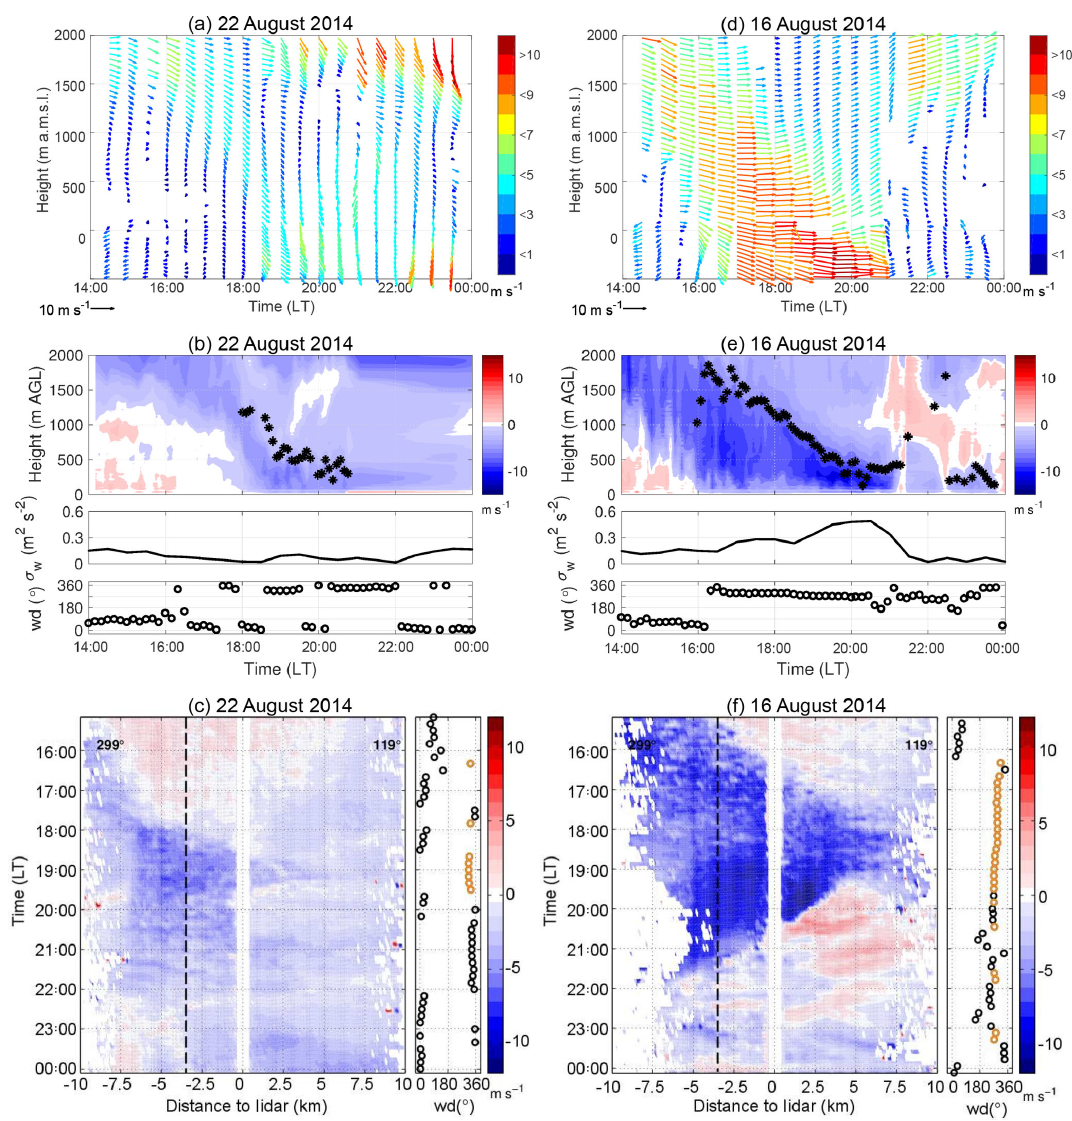
Figure 5. Example for a short and weak foehn event (a, b, c) and for a strong foehn event (d, e, f) . Shown are 10min mean vertical profiles of horizontal wind at the KITcube location (a, d) . Length and colours of the arrows represent wind velocity and the direction of the arrows indicate the horizontal wind direction. Time–height cross sections of the averaged vertical profiles of the horizontal radial wind component derived from lidar RHI scans at 299 ◦ (b, e) . Negative values (blue colours) indicate a wind component from north-west and positive values (red colours) indicate a wind component from south-east. Black stars indicate the detected height of the foehn. Below the cross sections the variance of the vertical wind ( σ w ) at 2ma.g.l. and wind direction (wd) measurements at 40m height are shown. Hovmoeller diagrams of the near-surface radial velocity from lidar RHI scans at an azimuth angle of 299 and 7 ◦ elevation west of the lidar and 1.6 ◦ east of the lidar (c, f) . The black dashed line indicates the end of the western slope and the beginning of the valley floor. Wind direction (wd) was measured at 40ma.g.l. Orange points highlight wind directions between 270 and 330 ◦ , the main wind direction of the